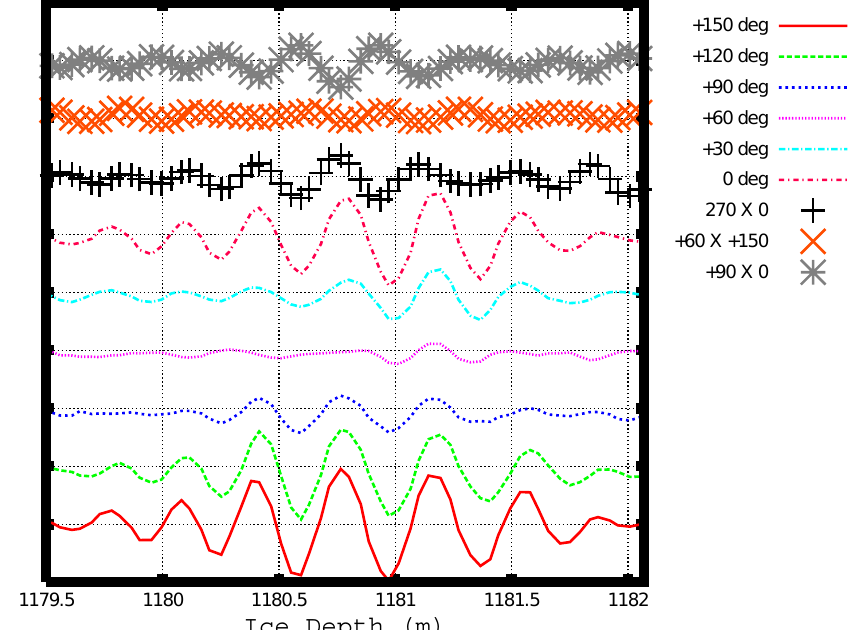
Fig. 7. Zoom of interval around 13.9µs. Vertical divisions correspond to 1 mV. No horizontal offset has been applied to successive waveforms. Each 0.5 meter division horizontally corresponds to approximately 5ns.